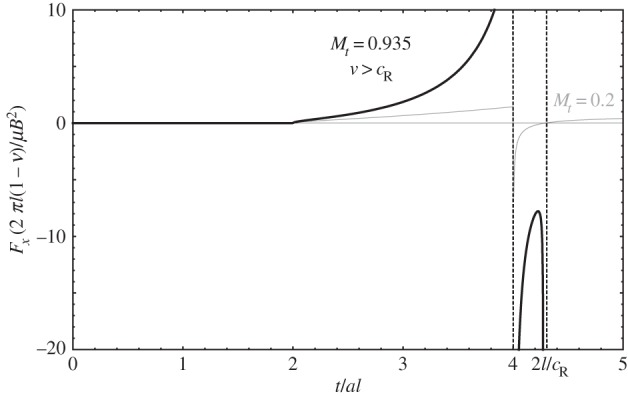
Image force for an injected dislocation moving uniformly with speed v=0.935ct, slightly larger than the Rayleigh wave speed, cR. Here R=a/b=0.5, so cR=0.9325ct.